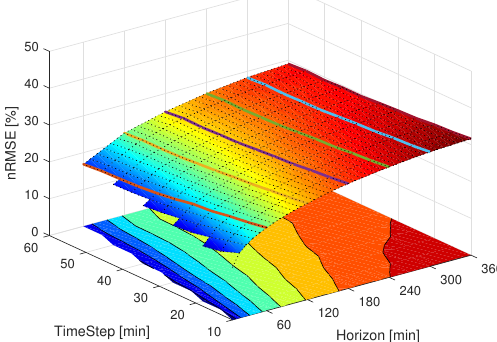
Figure 8. Interpolated results for Ajaccio. The colored lines are extracted to Figure 10a.